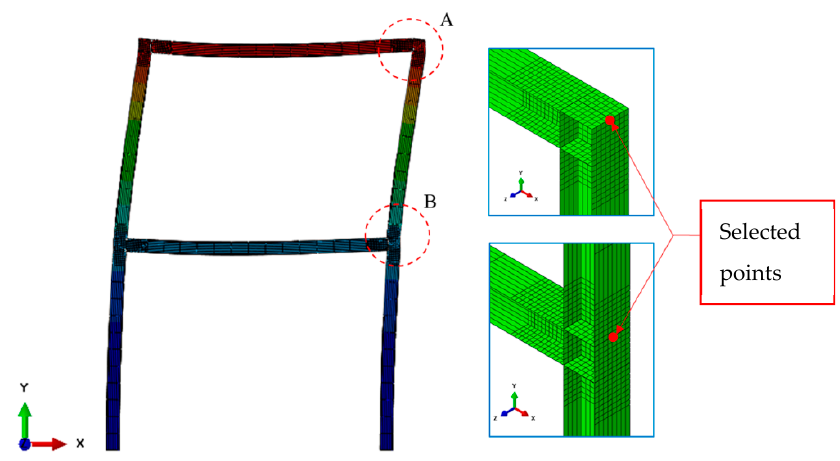
Figure 21. Selected points for structural displacement location.